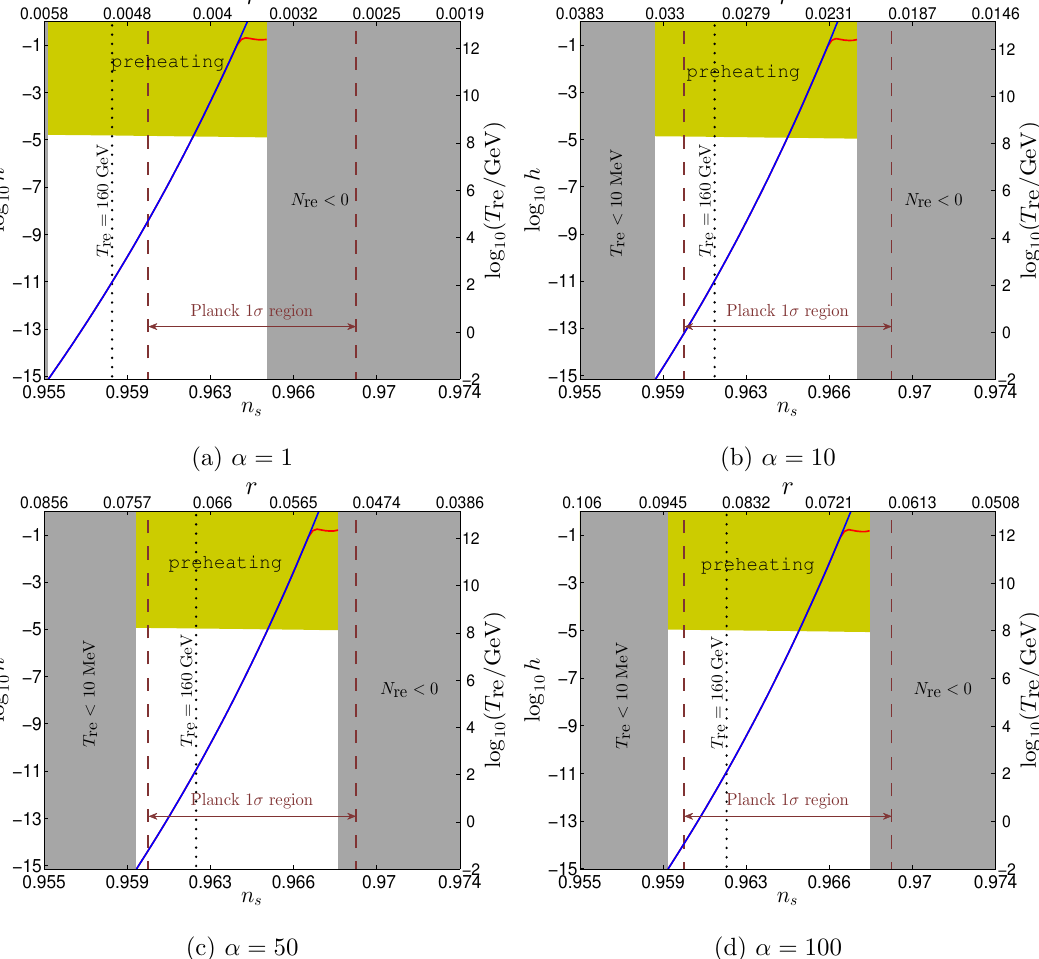
Figure 9. For (cid:12)xed (cid:11) and n , the coupling constant h in the interaction h(cid:30)(cid:31) 3 = 3! can be determined from n s . The solid lines are plotted from eqs. (3.29) (blue line) and (A.15) (red line) for